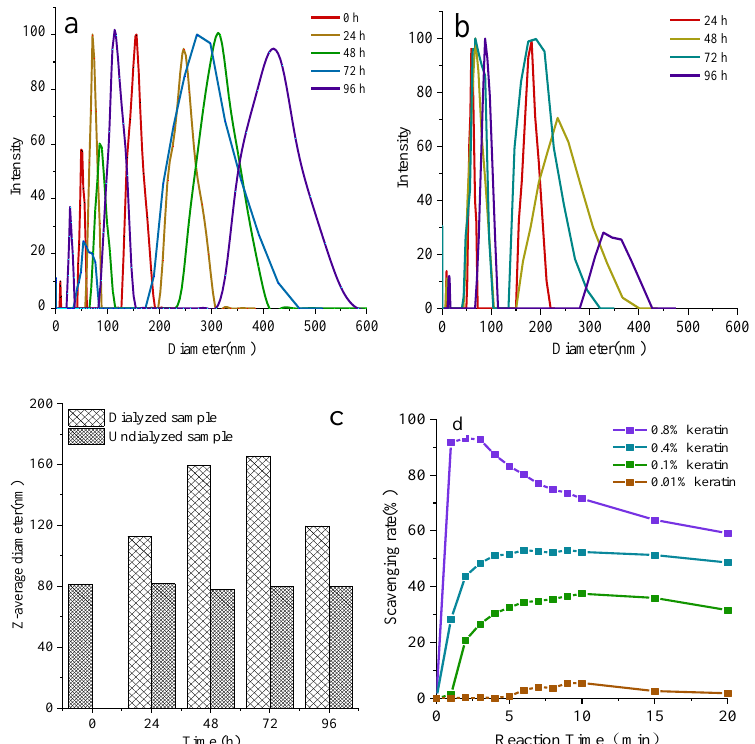
Figure 5. Dynamic light scattering of keratin in ultrapure water with generated plots measuring intensity%, ( a ) Dialysis samples at different times ( b ) Undialyzed sample ( c ) Average diameter of the two samples ( d ) Superoxide anion free radical scavenging test.